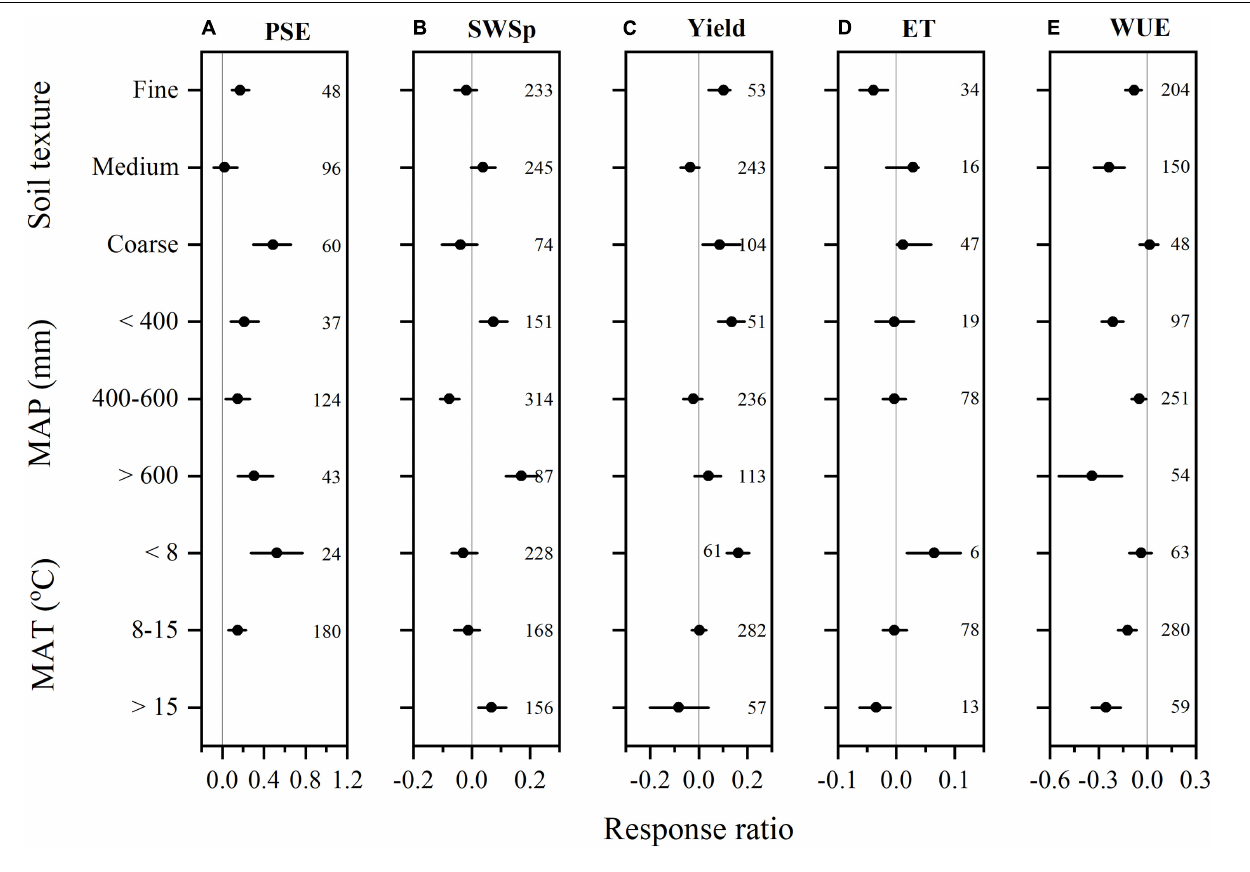
FIGURE 5 | The mean response ratios of precipitation storage efficiency (PSE, A ), soil water storage at wheat planting (SWSp, B ), winter wheat grain yield (C) , evapotranspiration (ET, D ), and water use efficiency (WUE, E ) to fallow mulching practices compared to no mulching and their bootstrapped 95% confidence intervals (Horizontal line) as affect by soil texture, mean annual precipitation (MAP), and mean annual air temperature (MAT). The reference line (RR = 0) specifies no variation between conservation tillage and conventional tillage. Numbers accompanying the bootstrapped 95% confidence intervals designate the number of observations for